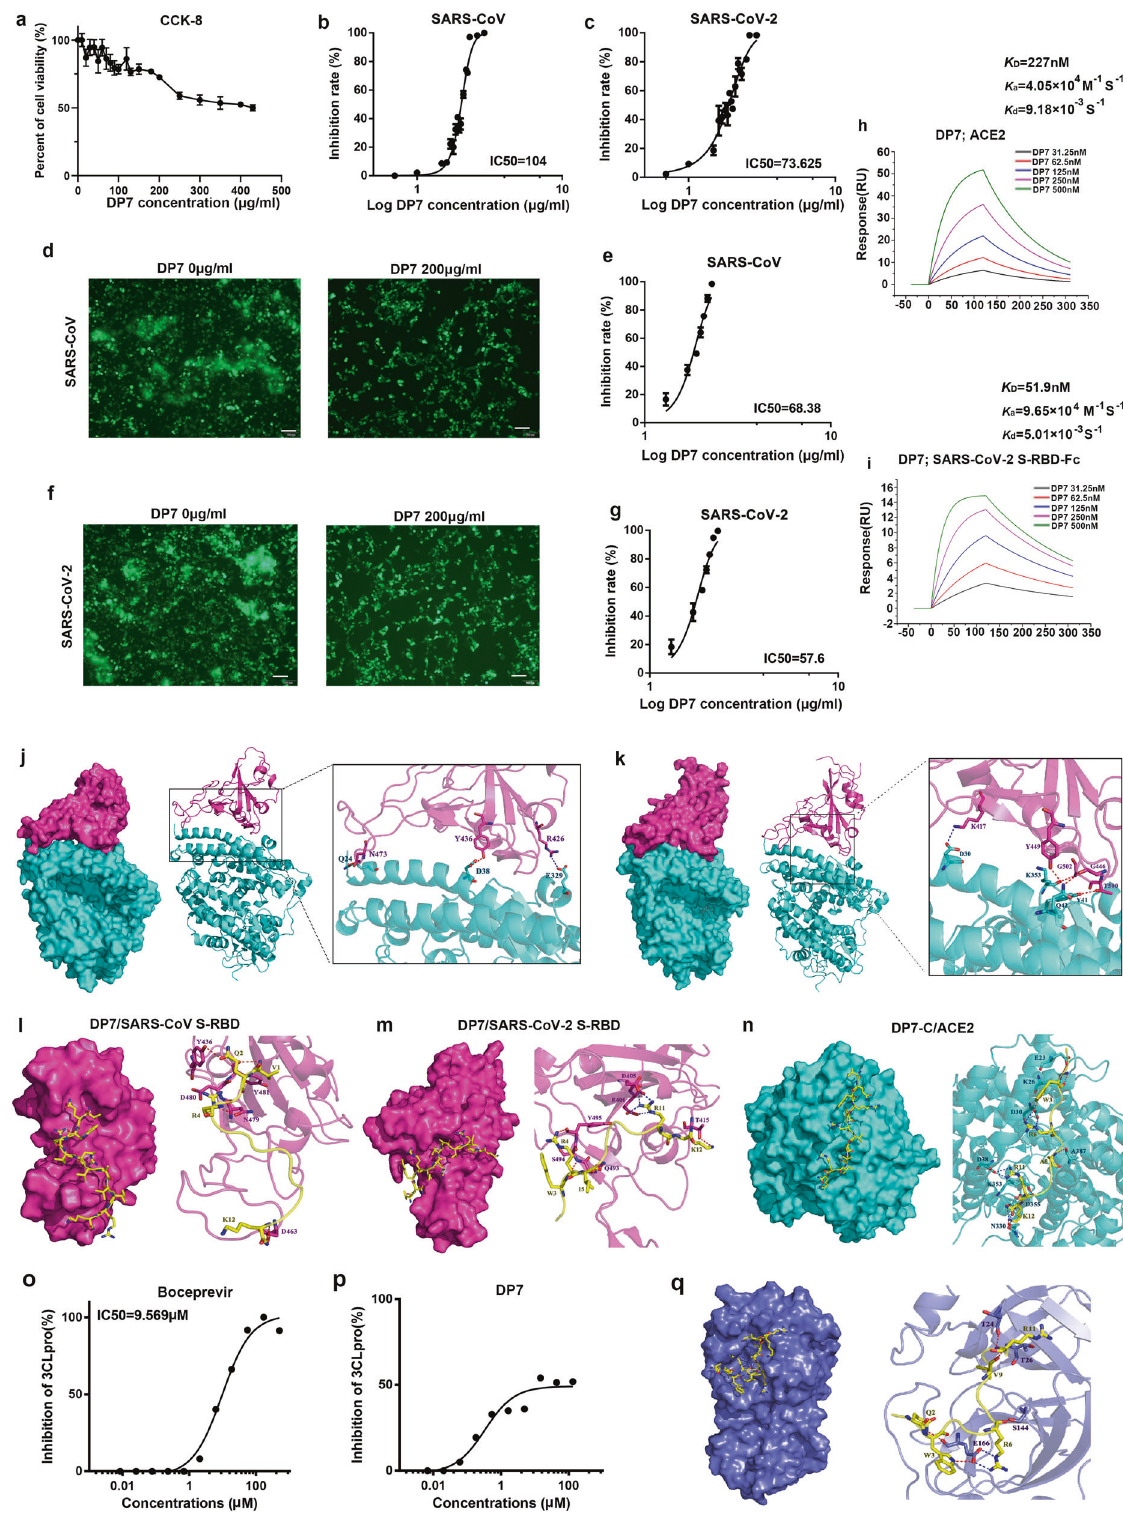
Fig. 1 DP7 showed potent inhibitory activity against SARS-CoV and SARS-CoV-2 infection. a Cytotoxicity test of DP7. DP7 inhibited the ef fi ciency of ( b ) SARS-CoV S protein pseudovirus and ( c ) SARS-CoV-2 S protein pseudovirus infecting ACE2-293T. DP7 inhibited cell – cell fusion mediated by ( d , e ) SARS-CoV S protein and ( f , g ) SARS-CoV-2 S protein. Surface plasmon resonance (SPR) sensorgram showing the binding kinetics for DP7 and ( h ) ACE2 and ( i ) S-RBD-Fc of SARS-CoV-2. Binding mode and interactions of ACE2 with ( j ) SARS-CoV S-RBD (PDB ID: 2AJF) and ( k ) SARS-CoV-2 S-RBD (PDB ID: 6LZG). Binding mode and interactions of DP7 with ( l ) SARS-CoV S-RBD, ( m ) SARS-CoV-2 S-RBD and ( n ) ACE2. Inhibitory activity of ( o ) boceprevir and ( p ) DP7 on SARS-CoV-2-3CLpro. q The surface binding model of SARS-CoV-2-3CLpro with DP7